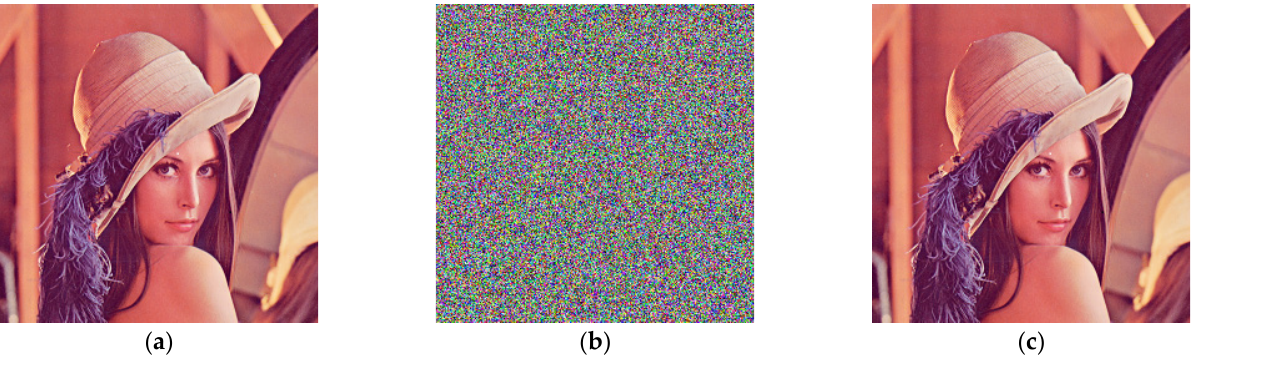
Figure 9. Experimental results, ( a ) plaintext, ( b ) ciphertext, ( c ) decrypted image.